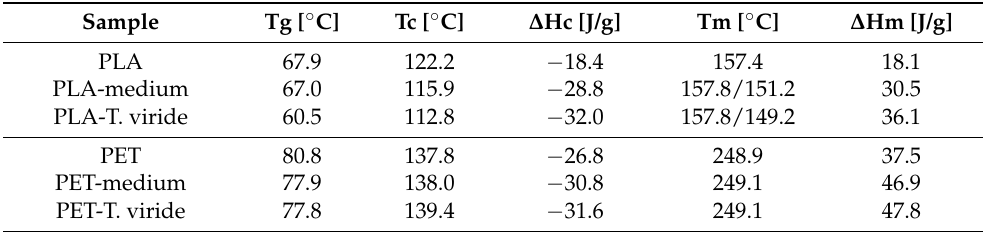
Table 1. DSC parameters of PLA and PET films before treatment, after 3-month incubation in medium, and after 3-month incubation in medium containing T. viride